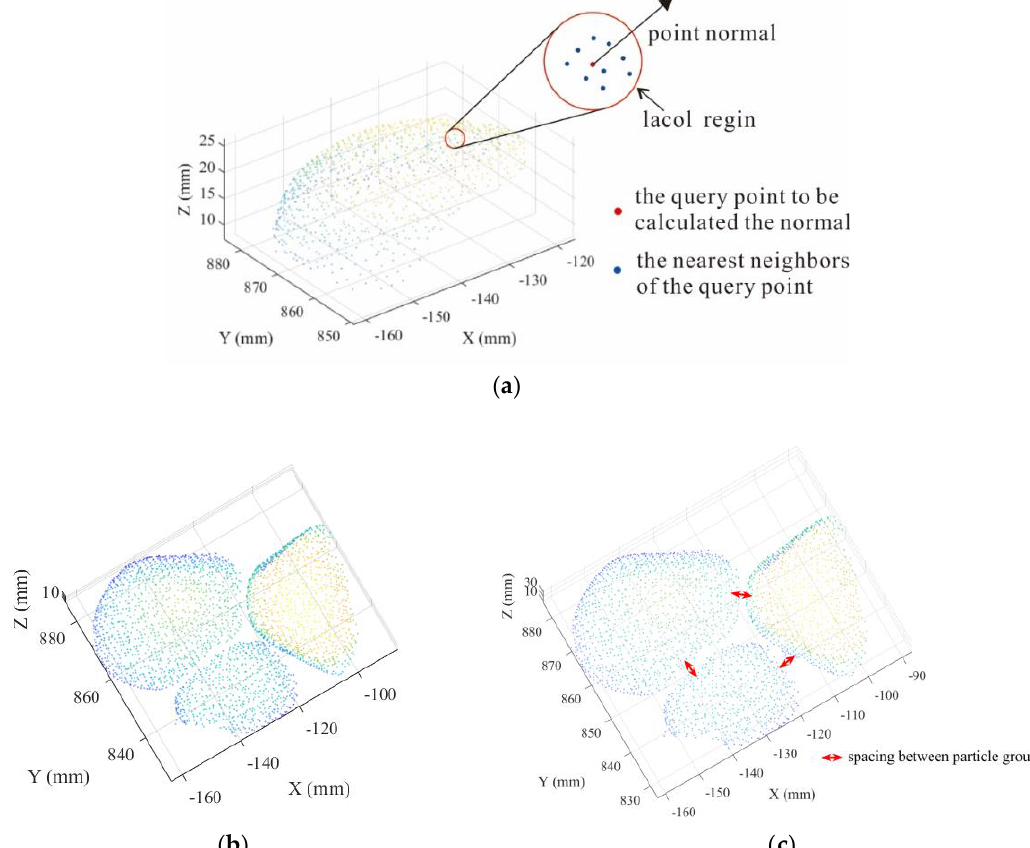
Figure 5. Schematic diagram of block separation; ( a ) definition of point normal, ( b ) original block point cloud, and ( c ) block point cloud of after separation.